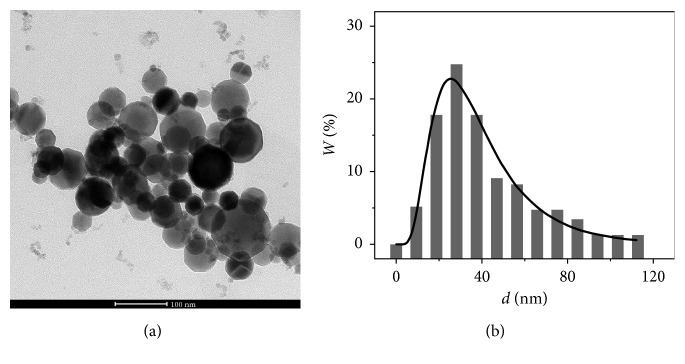
Bright field TEM image (a) and size distribution (b) of Fe3O4 nanoparticles.